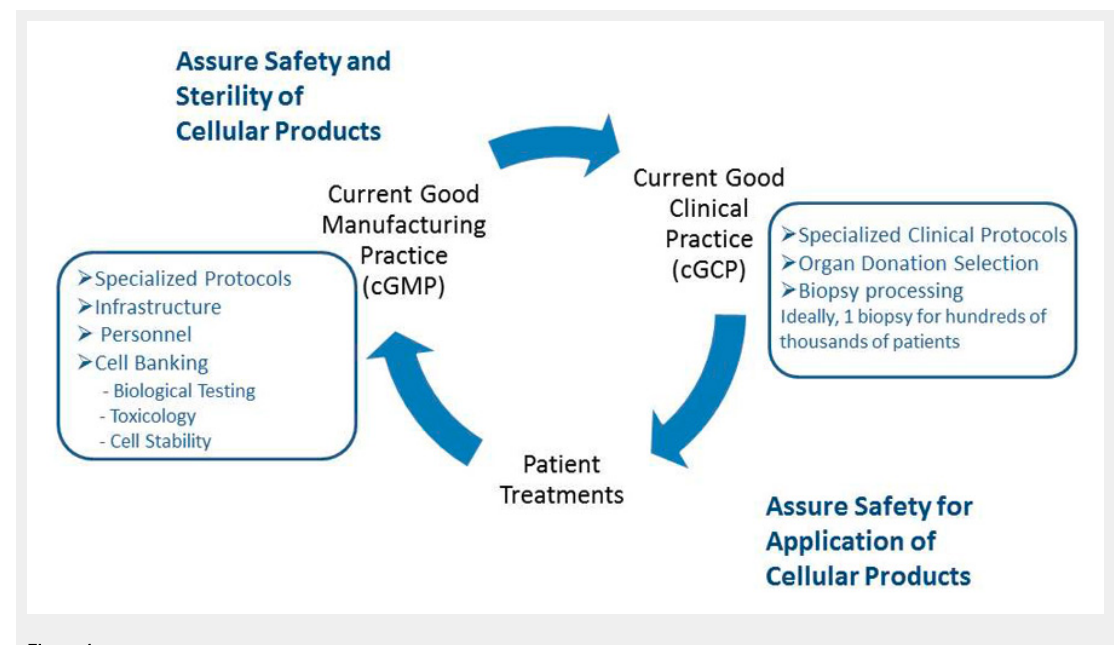
Figure 4 Good Clinical Practice and Good Manufacturing Practice associated with cellular therapeutics. Current Good Clinical Practices (cGCP) are necessary to begin the process of cellular therapies and tissue engineering with detailed protocols for organ donation and biopsy processing. Tissue and cellular handling then needs to abide by Current Good Manufacturing Processes (cGMP) which include specific protocols for infrastructure, equipment and personnel. cGCP is then needed for appropriate administration of cellular therapies. Thus, the entire process requires high collaboration between biologists, technicians, nurses and